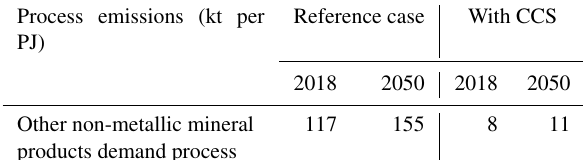
Table 11. Prerequisite heat pump requirement.